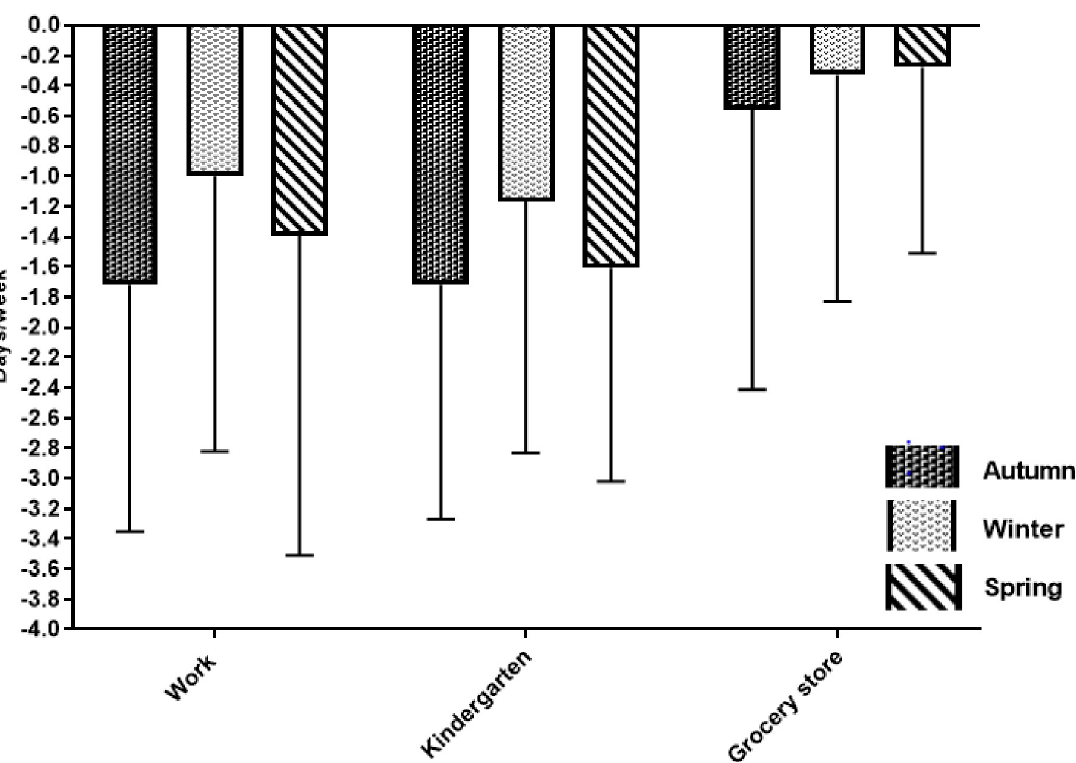
Fig 3. Change in frequency of driving. Change (mean (SD), days/week) in frequency of driving a car from baseline to follow-up in the intervention group (n = 18), grouped according to destinations (work, kindergarten, grocery store) for the autumn, winter and spring seasons respectively. Follow-up measures were conducted after 3, 6 and 9 months, i.e. following the autumn, winter and spring season.